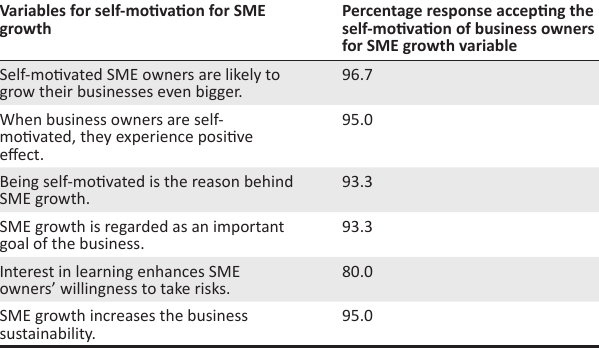
TABLE 2: Self-motivation of business owners for small and medium enterprise growth. Variables for self-motivation for SME growth